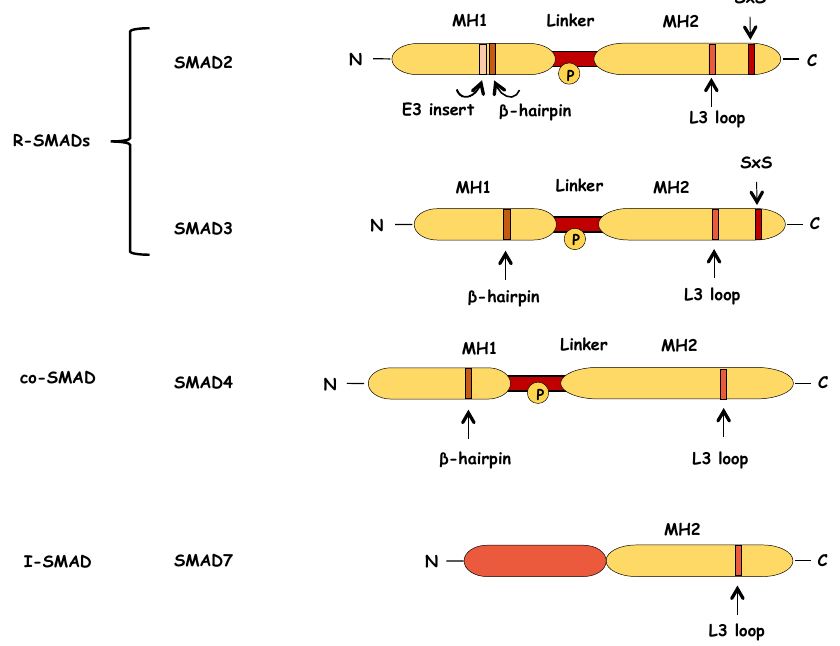
Figure 5. Schematic representation of structure of the SMAD proteins. R-SMAD and SMAD4 proteins consist of two highly conserved domains, the MH1 and MH2 domains, which are separated by a non-conserved linker region. The N-terminal MH1 domain of R-SMADs contains a β-hairpin structure that is critical for DNA binding. In the case of SMAD2, the MH1 domain contains also an extra amino-acid sequence (E3 insert) that negatively regulates the DNA binding capacity of SMAD2. The C-terminal MH2 domain of R-SMADs contains an L3 loop that mediates the interaction between R-SMADs and the activated type I receptor. This L3 loop is also part of the SMAD4 structure and it is important for the formation of SMAD trimeric complexes. At their very C-terminus, R-SMADs, have a short conserved motif of two serines separated by one amino acid (Ser-X-Ser (SXS)) that are phosphorylated by the activated type I receptor, thus leading to the R-SMAD activation. The linker region encompasses multiple phosphorylation sites (P in circle), and it is targeted by various kinases that modulate SMAD stability and function. SMAD7, the inhibitory SMAD, retains the conserved MH2 domain but lacks the SXS motif at the C-terminus and the N-terminal region presents small similarity to the MH1 domain.